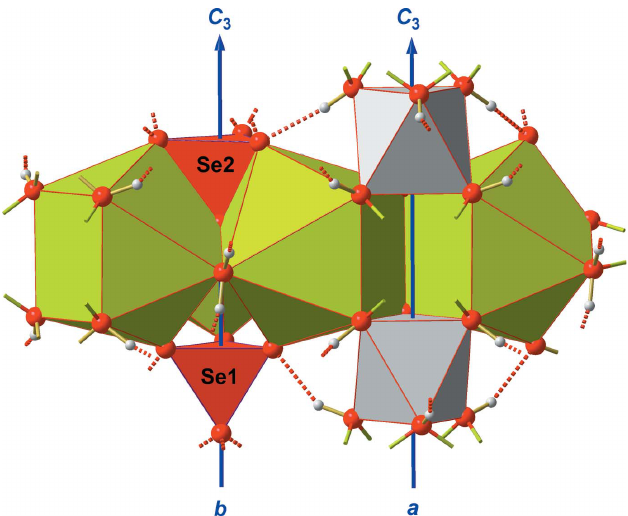
Figure 4 Polyhedral model showing the interconnection of the PBUs (selenate ions in red, {BaO 9 } coordination polyhedra in green, [Sn(OH) 6 ] 2 (cid:3) ions in gray) and their orientation with respect to the different threefold rotation axes (blue, letter = Wyckoff position) of space group P 6 3 . Oxygen atoms (red) and hydrogen atoms (gray) are drawn as spheres of arbitrary radius. Hydrogen bonds are indicated as broken red sticks, visible Ba—O coordinative bonds as shortened, two-colored sticks, and visible Sn—O Figure 3 bonds as shortened, brass-colored sticks. In order to show the linkage of Ball-and-stick model of the mono-capped, square-prismatic {BaO 9 } the SBUs and to visualize the trigonal–prismatic void between the coordination polyhedron. Atom colors and bond design as in Fig. 2. hexahydroxidostannate ions, one additional {BaO 9 } coordination poly- Symmetry codes: (1) y , 1 (cid:3) x + y , 1 + z ; (2) 2 (cid:3) x , 1 (cid:3) y , 1 + z ; (3) 1 (cid:3) y , 2 2 hedron and one additional [Sn(OH) 6 ] 2 (cid:3) ion are also shown. x (cid:3) y , z ; (4) 1 (cid:3) x + y , 2 (cid:3) x , z ; (5) 1 + x (cid:3) y , x , 1 + z . 2